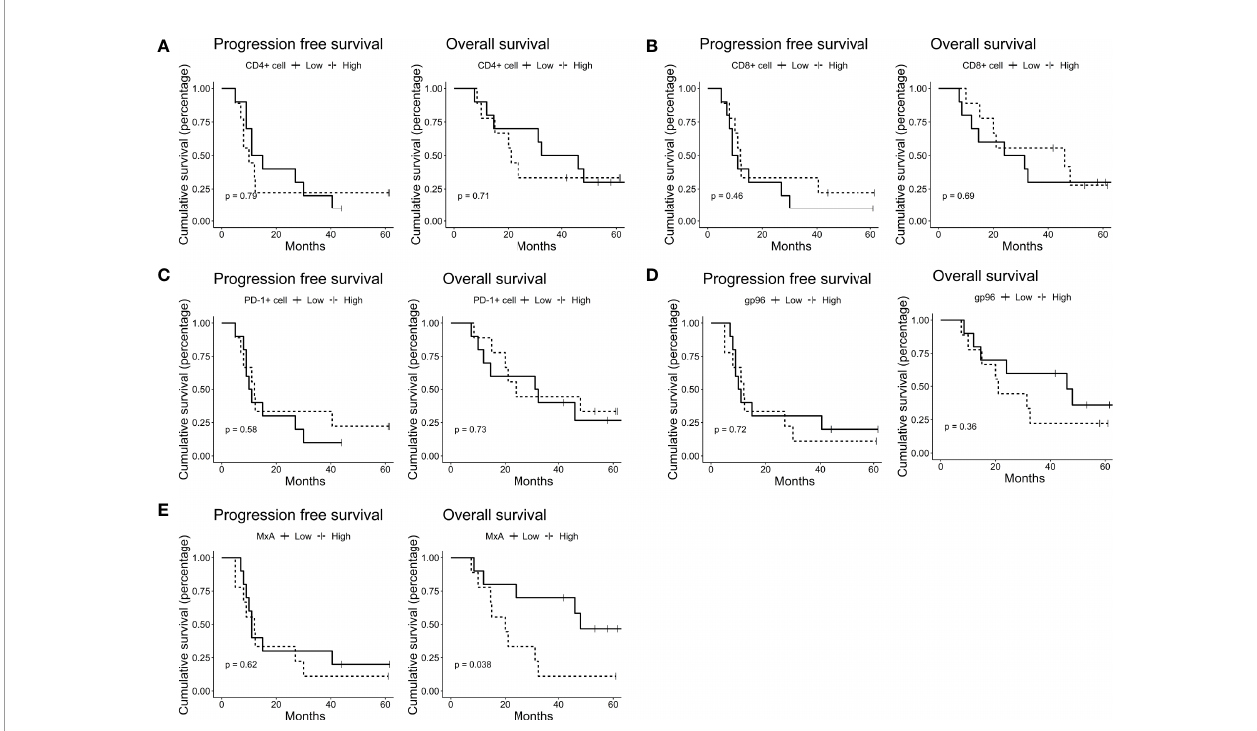
FIGURE 2 | Low MxA expression was associated with favorable prognosis. Kaplan – Meier estimates of progression-free survival and overall survival in HSPPC-96- vaccinated GBM patients, grouped by the median CD4+ (A) CD8+ (B) and PD-1+ cell (C) densities and gp96 (D) and MxA (E) expression. Log-rank tests were applied to estimate differences. Vertical lines indicate censored time